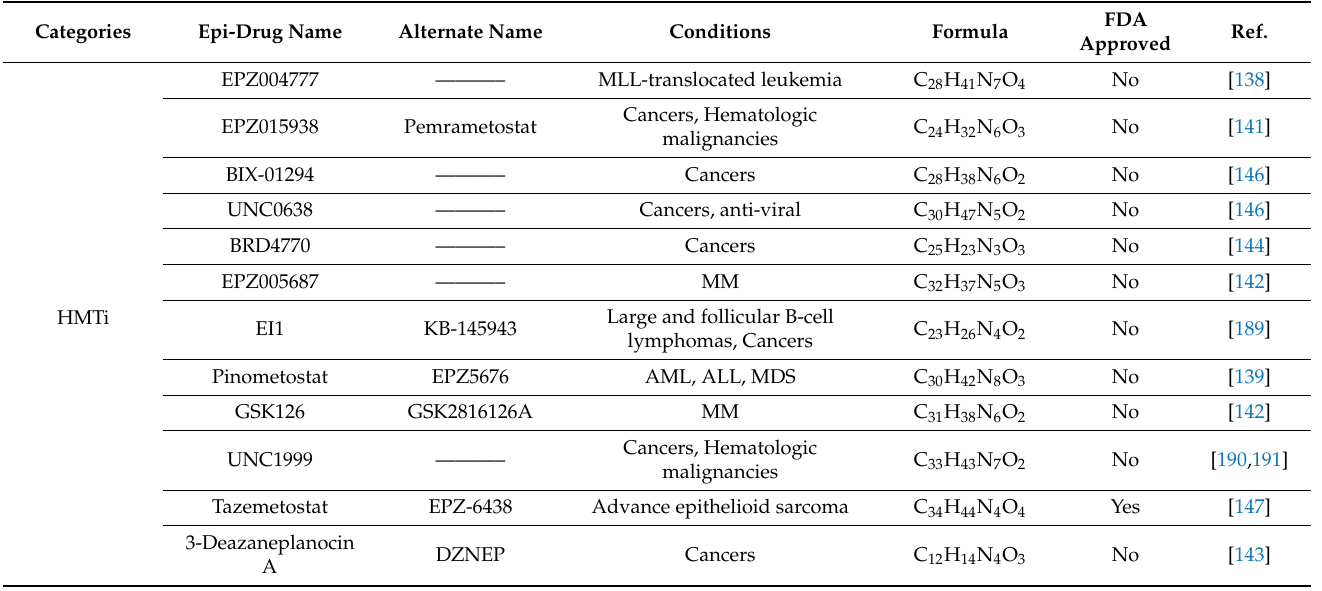
Table 2. Epigenetic drugs to inhibit into four groups of enzymes (HMTi, HDMi, HATi and